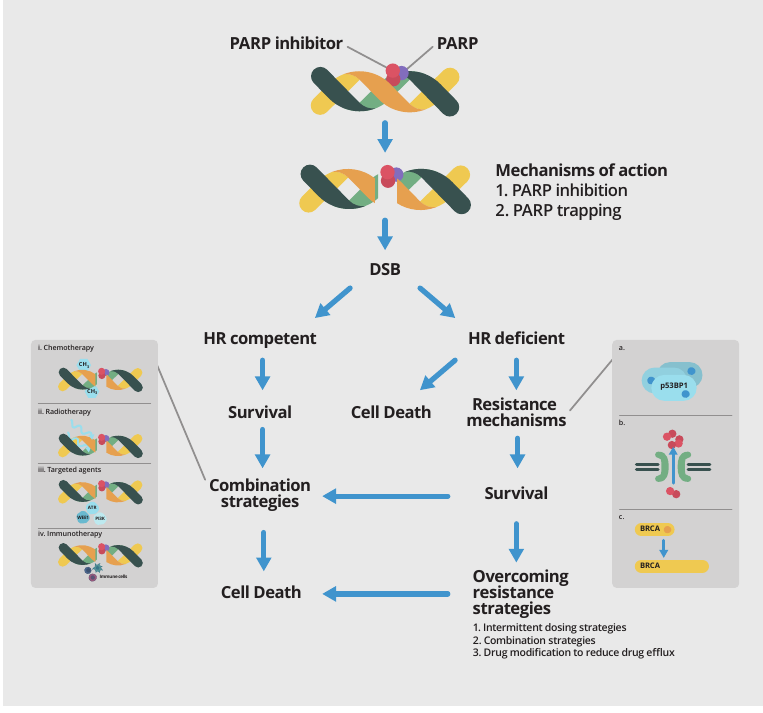
Figure 1. PARP inhibitors cause DNA DSB (double strand break) by via inhibition of PARP enzyme activity and PARP trapping. In HR (homologous recombination) competent tumors, tumor cells with intact homologous recombination repair will be able to survive. However, in BRCA1/2 mutant and other HR deficient cancers that are reliant on base-excision repair based on the PARP pathway, blockade of this pathway by PARP inhibition leads to synthetic lethality and cell death. Multiple resistance mechanisms against PARP inhibitors have been elucidated, including somatic mutations in p53BP1 ( a ); upregulation of drug efflux transporters such as PgP ( b ); and somatic mutations in BRCA gene leading to restoration of the open reading frame and thus BRCA function ( c ). Strategies to overcome resistance include intermittent dosing, combination strategies and drug modification to reduce drug efflux. Various combination strategies are currently underway to further exploit the role of PARP inhibitors, including combination with chemotherapy ( i ); radiation therapy ( ii ); targeted agents ( iii ) and immunotherapy ( iv